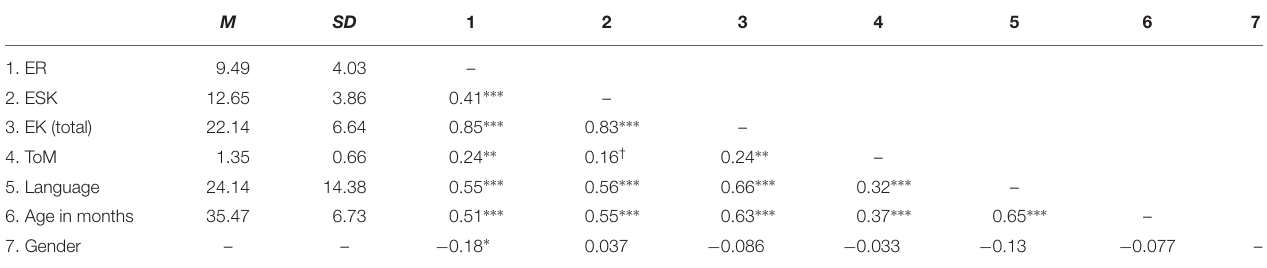
TABLE 1 | Means, standard deviations, and zero-order correlations among the study